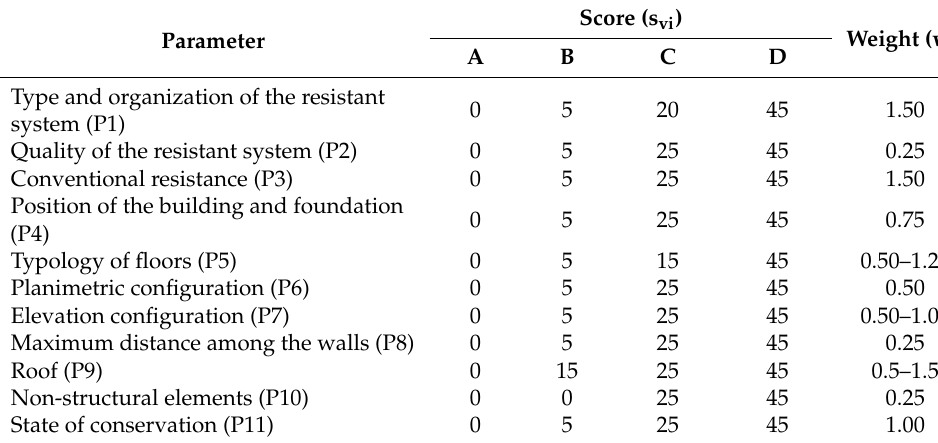
Table 1. Vulnerability parameters and their weights.